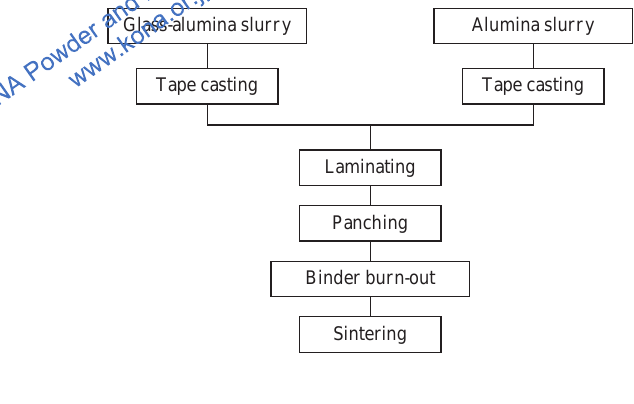
Fig. 2 Process chart of